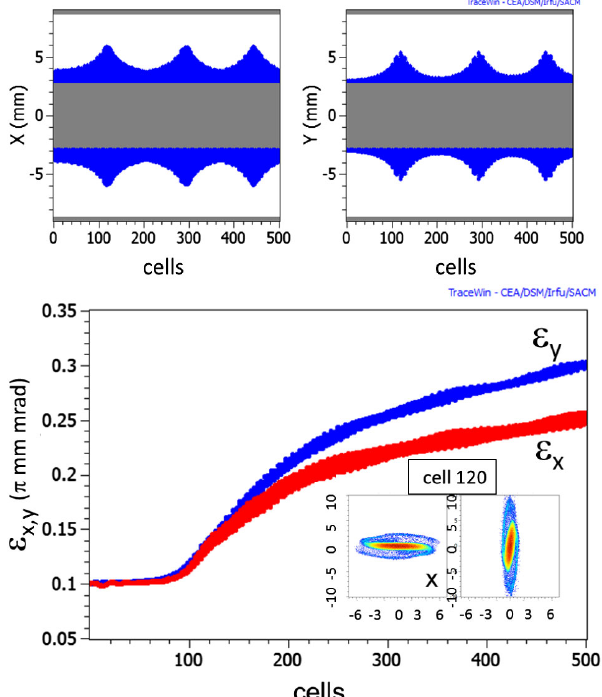
FIG. 8. Top graph: KV-envelopes versus cell number for ¼ 60 °, k ¼ 140 °; bottom graph: simulation results for k 0 ;x 0 ;y rms emittances versus cell number for waterbag distribution, with phase space inserts at cell